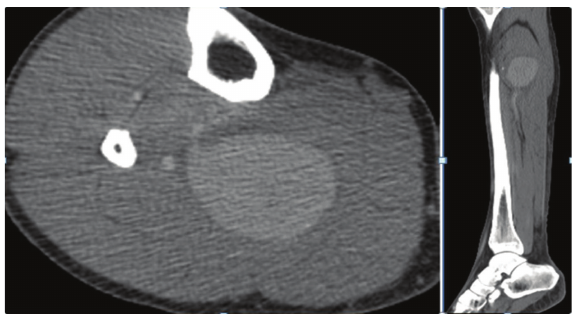
Figure 1: The giant posterior tibial artery aneurysm was diagnosed by angio-CT scan.